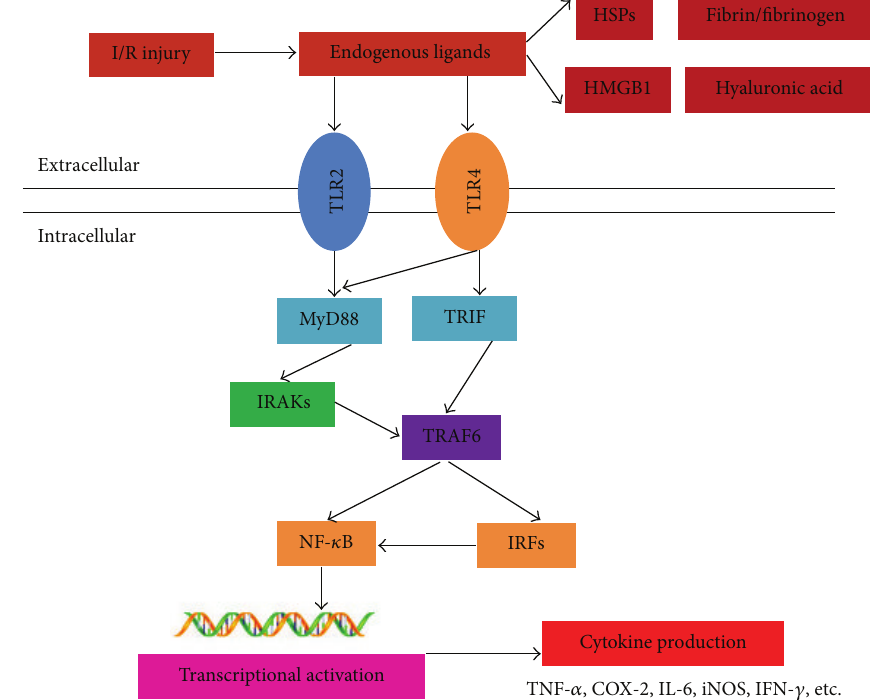
Figure 1: Brain injury caused by cerebral ischemia/reperfusion is a complicated pathophysiological course, in which TLR2 and TLR4 are thought to play an important role. TLR2 and TLR4 play crucial roles in modulating inflammatory response caused by cerebral ischemia and reperfusion via linking to their endogenous ligands and then recruit specific adaptors within cells. TLRs signal activates the transcription factors and generates cytokines and chemokines via intracellular